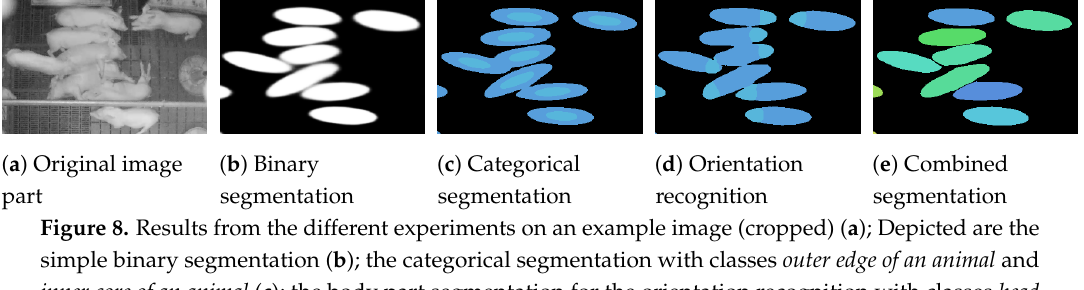
Figure 8. Results from the different experiments on an example image (cropped) ( a ); Depicted are the simple binary segmentation ( b ); the categorical segmentation with classes outer edge of an animal and inner core of an animal ( c ); the body part segmentation for the orientation recognition with classes head and rest of the body ( d ) and the combined segmentation with the results of the clustering, masked with the binary segmentation ( e ).